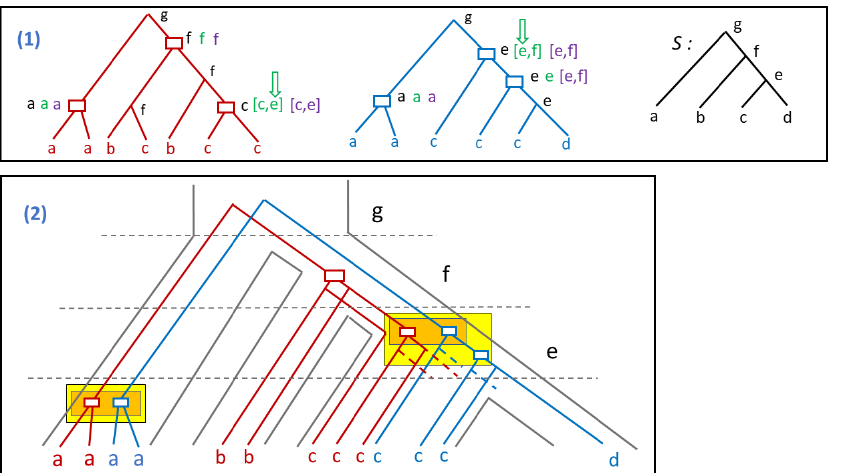
Figure 6. ( 1 ) Two gene trees (red and blue) and a species tree S . Leaves of the gene trees are labeled according to the genome the corresponding gene belongs to. The event-labeling of internal nodes correspond to the LCA-mapping (rectangles are duplications and the other nodes are speciation). The interval labeling Int ( d ) is given for each duplication node d (a single letter l corresponding to the interval [ l , l ] ): the black label corresponds to the LCA-mapping, the green interval to the GMS-model and the purple interval to the PG-model; ( 2 ) The two gene trees embedded in the species tree S . The duplication positions are chosen from the GMS-model intervals, and indicated by a green arrow in ( 1 ). The orange boxes correspond to the multiple duplications according to the ME model, while the yellow boxes correspond to the multiple duplications according to the EC